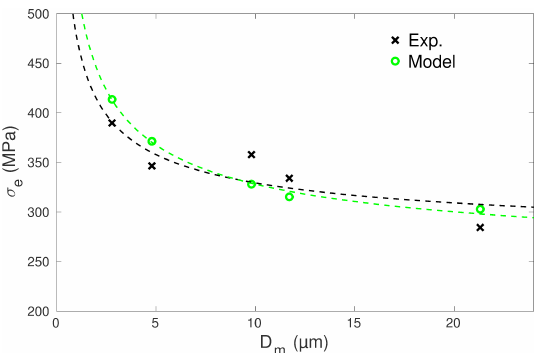
Figure 7. Comparisons of experimental and calculated values of the yield stress σ e with respect to the mean grain size D m for the specimens of RR type. Linear fit estimates obtained by MATLAB between √ D m are shown in green (Model) and black (Exp.) dotted σ e and 1/